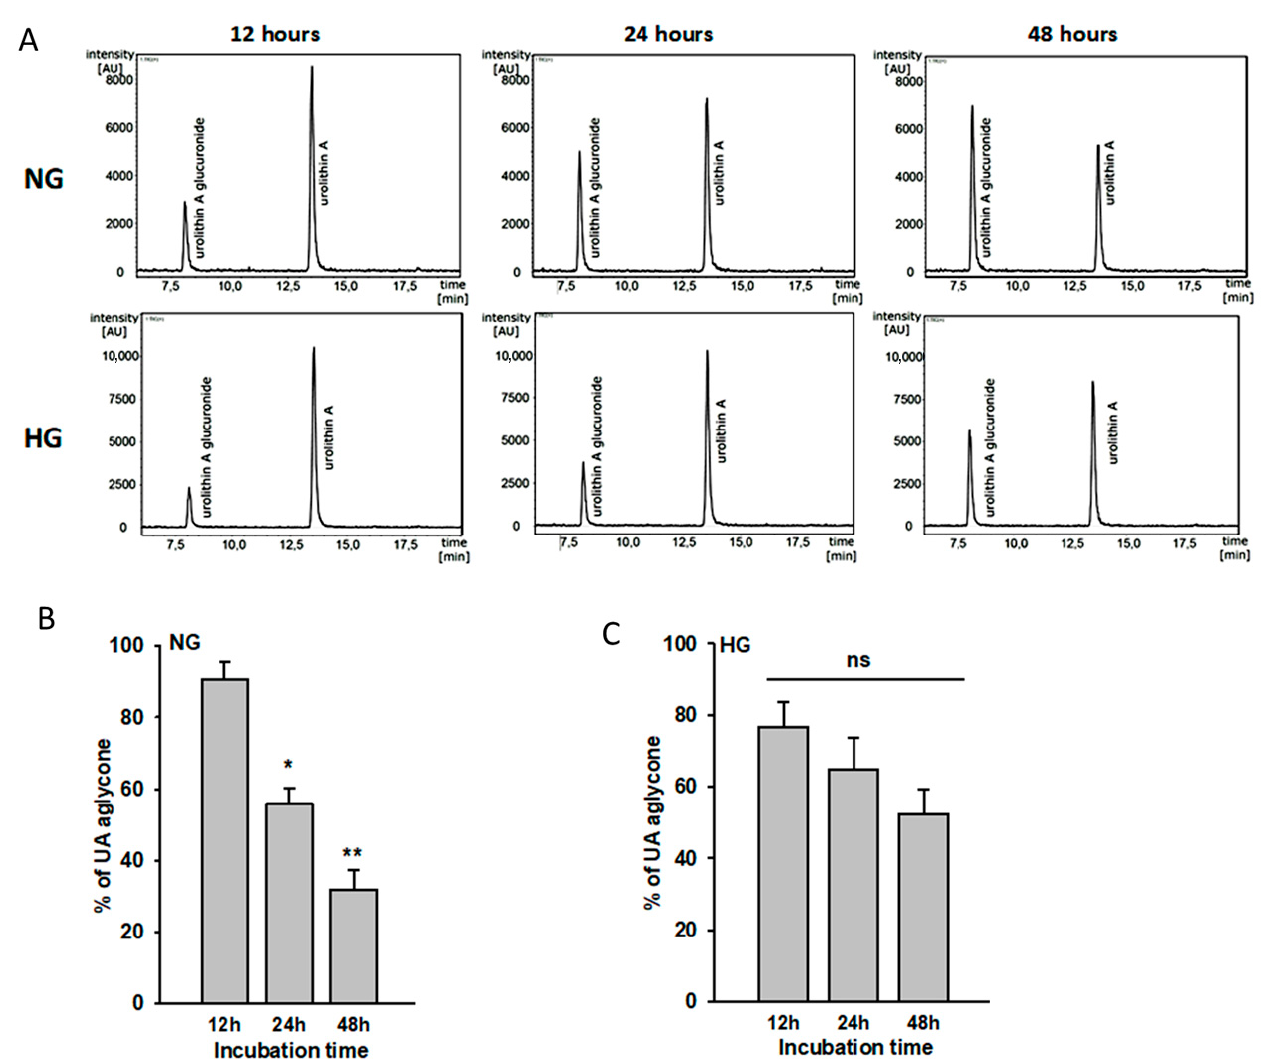
Figure 2. Urolithin A is metabolized by podocytes. Podocytes cultured for 7 d in normal (5.5 mM, NG) or high (25 mM, HG) glucose were incubated with 10 µM UA for the indicated time periods. At time 0, concentration of UA aglycone was 10 µM (100%). The presence of urolithin and its glucuronide in the culture medium was assessed using HPLC-DAD-MS/MS after 12 h, 24 h, and 48 h of incubation ( A ). Calculated results ( B , C ) show percentage of free aglycone detected in culture media and are expressed as mean ± SEM from three independent experiments performed in duplicate. The Student’s t -test was used to calculate p values. * p < 0.01 24 h vs. 12 h, ** p < 0.003 48 h vs. 12 h. AU: arbitrary units; ns: not significant.